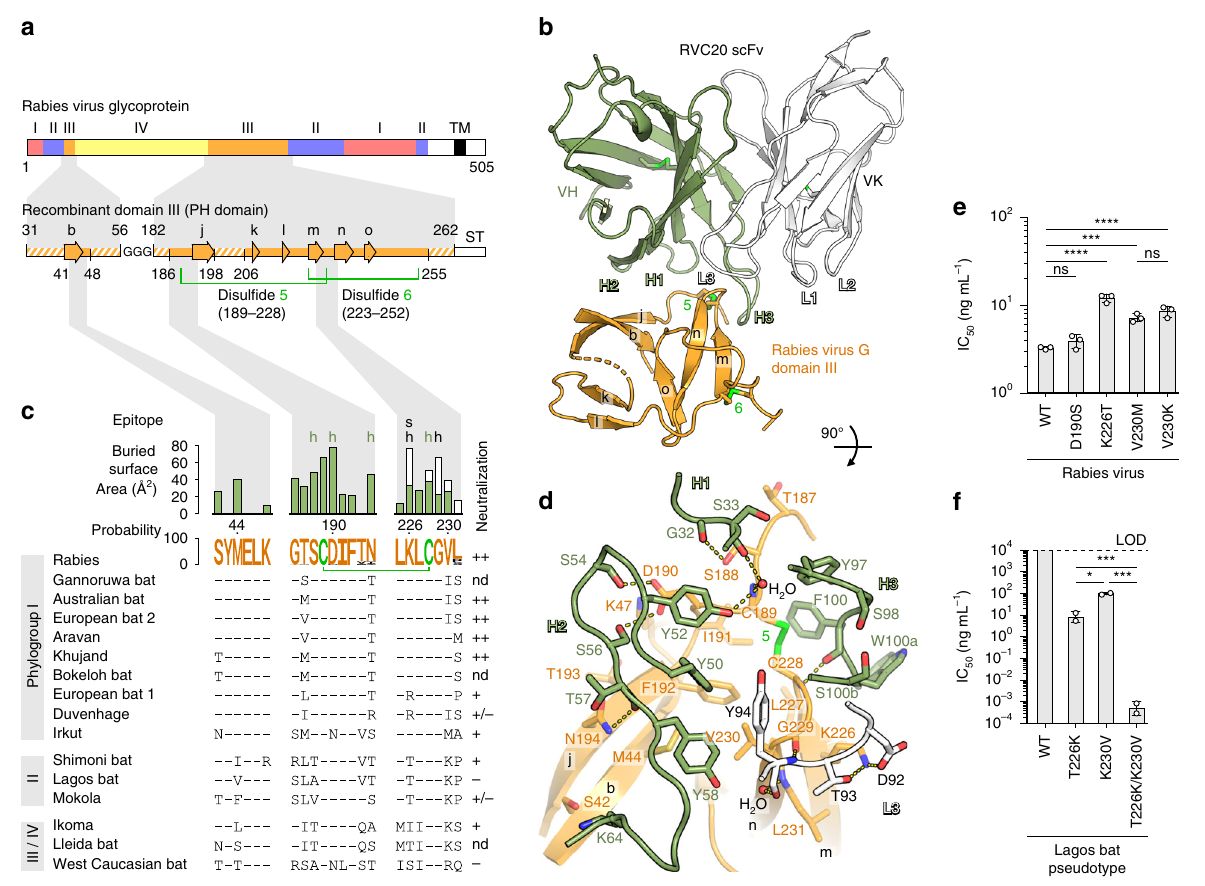
Fig. 1 RABV G recognition by RVC20. a Domain organization of RABV G (top row) as inferred by homology to VSV G 10 , and design of the recombinant domain III construct for structure determination (bottom row). Hatched fi elds in the construct denote unresolved regions in the X-ray structure. β strands are shown as arrows labeled in lower case in accordance with the VSV G structure 10 . TM transmembrane region, ST Strep tag. b Crystal structure of the complex between RABV G domain III and the RVC20 scFv. The variable domain of the heavy chain (VH) is shown in green, the variable domain of the kappa light chain (VK) is shown in white and the antigen is shown in orange. The CDRs of the mAb and the β strands and disul fi de bonds of the antigen are labeled. c Sequence conservation of the tripartite epitope. The RABV G sequence is displayed as a sequence logo, indicating the conservation per residue across 1412 unique full-length RABV G sequences in GenBank (details are listed in Table 2). The color-coded bar chart shows the BSA per RABV G residue in the complex contributed by heavy chain (green) and light chain (white) residues. h, hydrogen bond involved; s, salt bridge involved. Differences in epitope sequence across the Lyssavirus genus are shown below, with the corresponding neutralizing potency of RVC20 qualitatively summarized to the right 9 : ++ , strong; + , attenuated; − , not detected; + / − , isolate-dependent; nd, not determined. d Detail of the interaction interface. Residues on both sides of the interface are labeled and are shown as sticks with oxygen atoms in red and nitrogen atoms in blue. Secondary-structure elements and disul fi de bonds are labeled as in b . e Neutralization of recombinant RABV mutants with mAb RVC20 on BSR cells 48 h after infection; n = 3 independent experiments. f Neutralization of wild-type and mutant Lagos bat virus G-pseudotyped lentiviruses with mAb RVC20 on BHK-21 cells 72 h after infection. LOD, limit of detection; n = 2 independent experiments. Data are displayed as means ± s.d. Statistical analysis was performed using Tukey ’ s test with α = 0.05. **** P